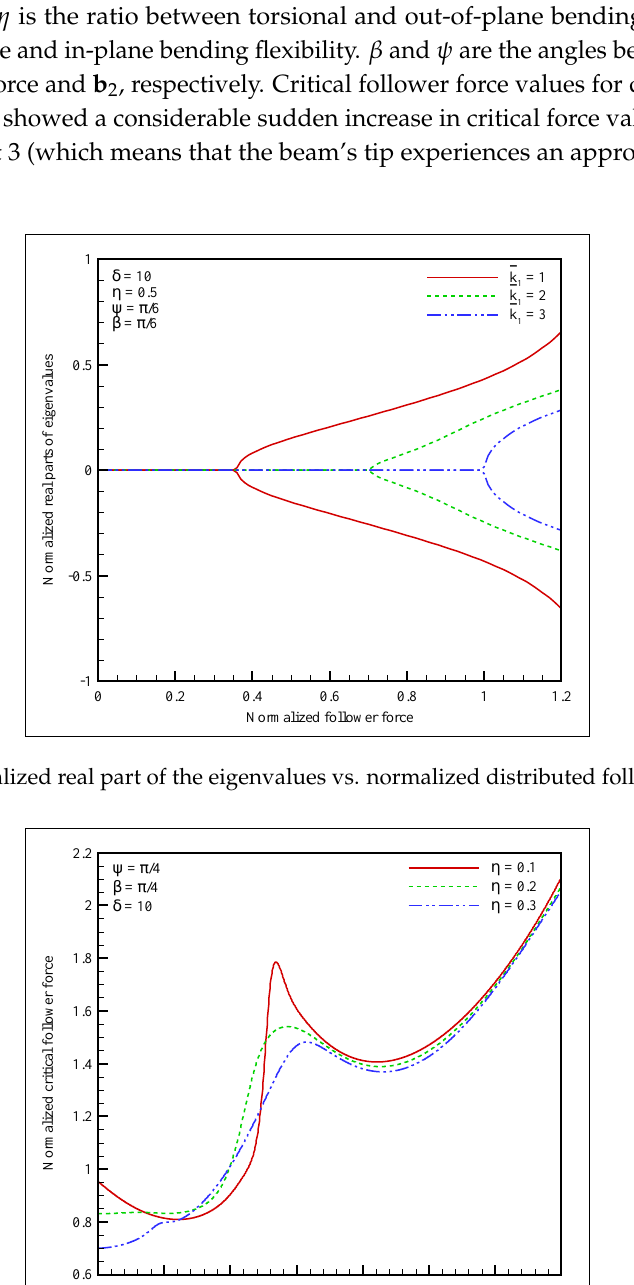
) vs. ¯ k 1 for η = 1, 2, 3; β = ψ = π rad; and δ = 10 [32]. 4 f N